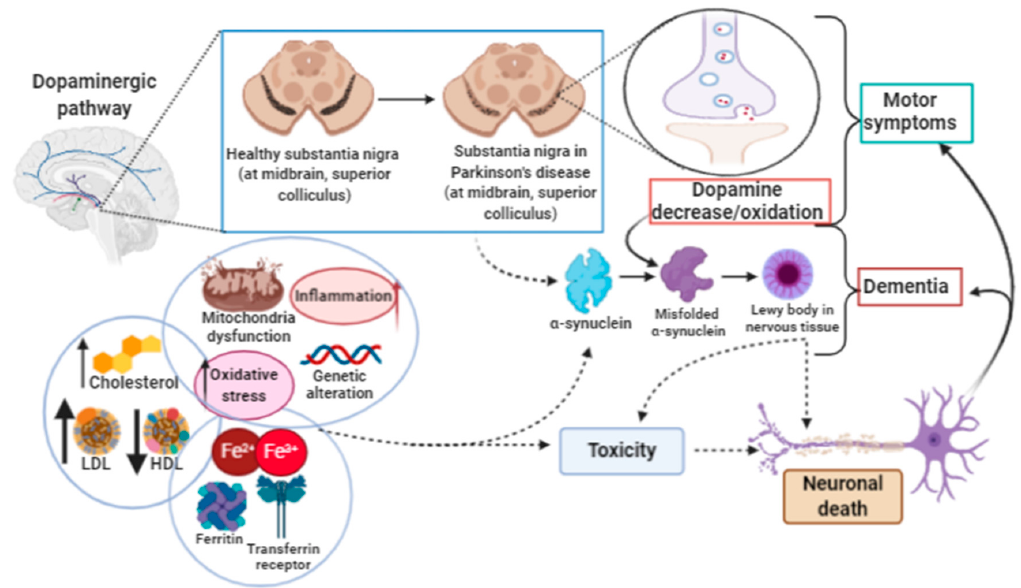
Figure 5. Parkinson’s disease. Parkinson’s disease (PD) occurs due to the decrease in and/or oxidation of dopamine in the substantia nigra, involving the motor system. The incorrect folding of α -synuclein leads to the accumulation of protein (Lewy body) in nervous tissue. The formation of Lewy bodies may be due to a highly pro-oxidative environment, due to dysfunction in the transport of lipids, iron, inflammation and mitochondrial changes. The increase in Lewy bodies is the trigger for the development of dementia, neurotoxicity and neuronal death.